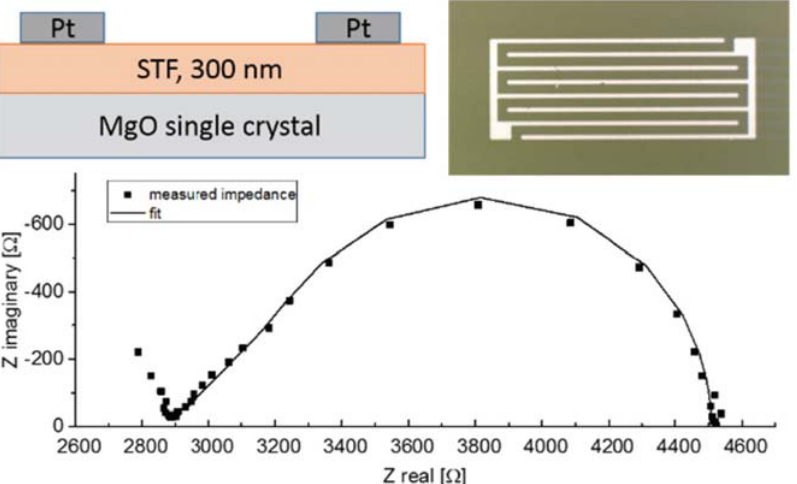
Fe )O (STF) thin film, deposited on an 0.3 0.7 3– δ